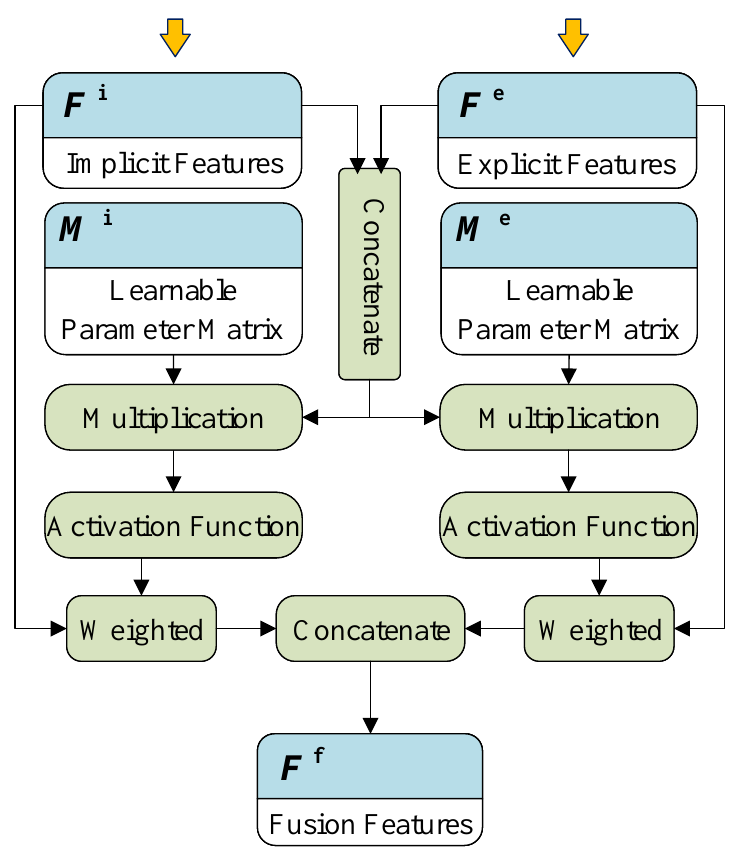
Figure 4. The workflow of the feature fusion